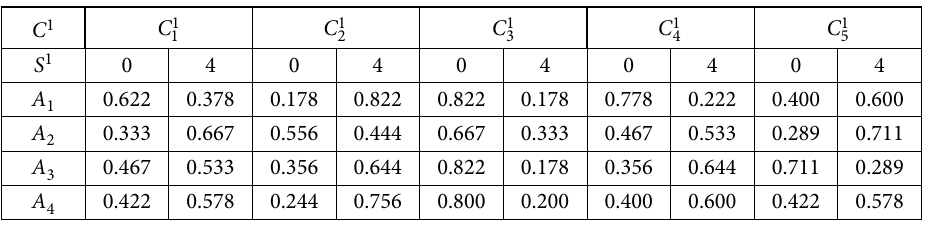
Table 3. Standardization value of dynamic distribution of visitor evaluation Data from the first survey